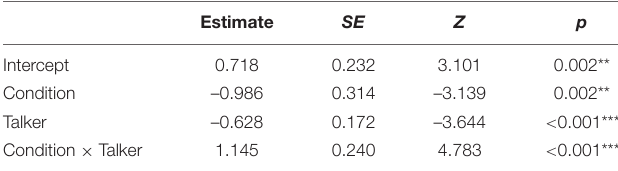
TABLE 1 | Fixed effect estimates for the best model results of the accuracy data in identifying SR-T3 words and CR-T2